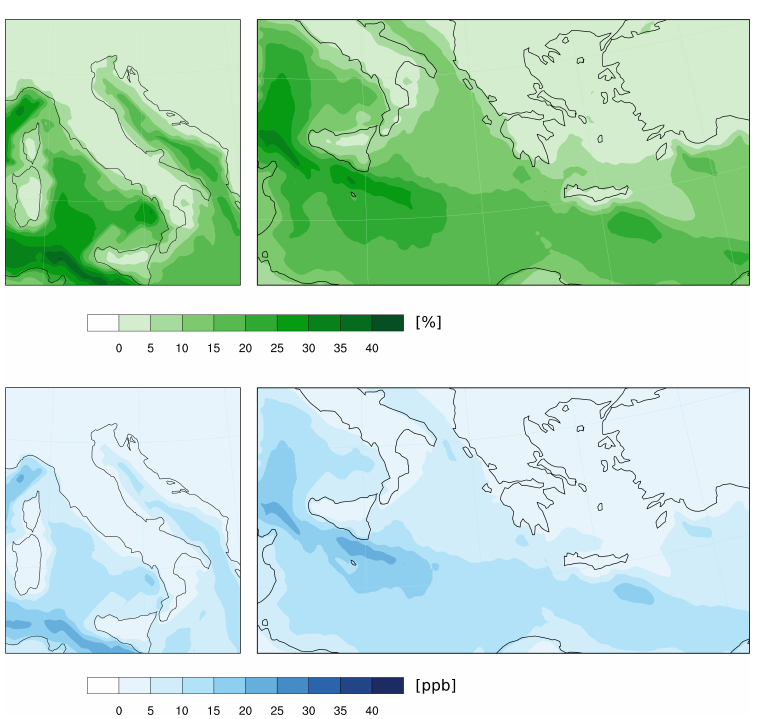
Figure 6. The average O concentration difference in the first model layer for 2005 ( Left ) 3 and 2006 ( Right ). Absolute difference (ppb) in the lower panel and percentage in the upper